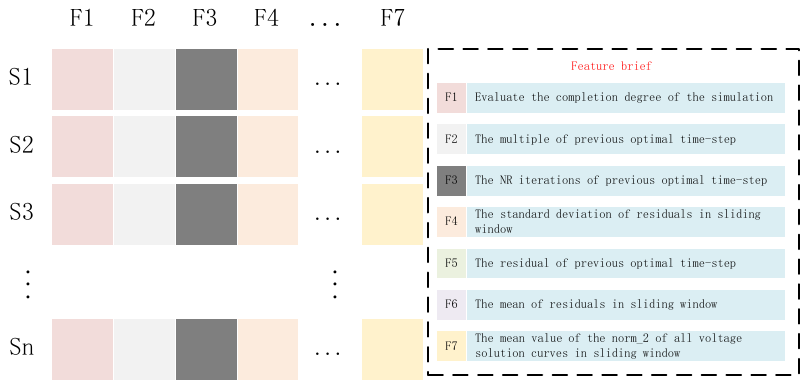
Figure 7. Diagram of the training set and feature